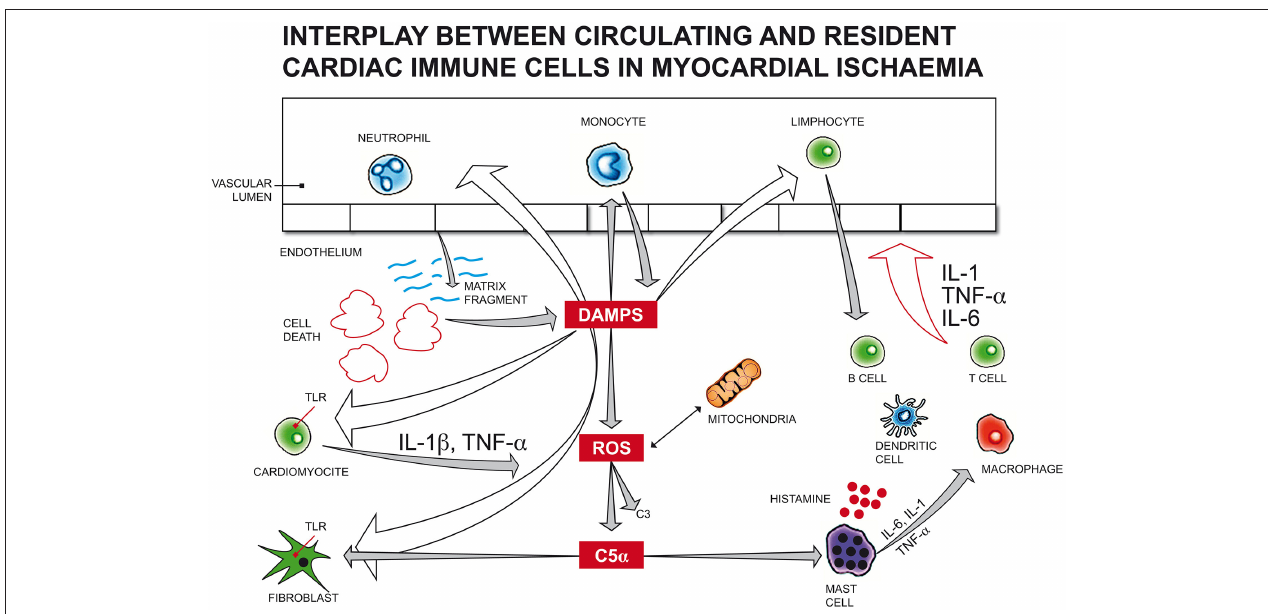
FIGURE 2 | Following myocardial infarction, cellular fragments released by dying or injured myocardial cells can trigger resident cardiac immune cells as endogenous “alarmins,” similar to microbial pathogen-associated molecular patterns (PAMPs) or damage-associated molecular patterns (DAMPs), through the engagement of membrane toll-like receptors (TLRs). Endogenous DAMPs can also activate the complement system, as observed with increased C3, C5 fragments in infarcted myocardial tissue, promoting leukocyte translocation in injured myocardium. Immune activation by DAMPs can arise also from mitochondrial DNA released by the mitochondria of damaged cardiac cells due to haemodynamic stress, inducing cardiomyocyte apoptosis. The generation of a large amount of reactive oxygen species (ROS) from mitochondria impairs myocardial function and activates leukocyte migration, reducing the number of vital cardiomyocytes and promoting extracellular matrix degradation. Many mediators of different origins can activate mast cells (MC) degranulation. In the first 24h after an acute ischaemic cardiac event, endogenous DAMPs induce the release of histamine, TNF- α , IL-6, prostaglandins, leukotrienes, tryptase, chymase and renin from MCs, leading to an acute immune response, which, in turn, actives resident immune cells, like macrophages, T, B, and dendritic cells. DAMPs, damage-associated molecular patterns; ROS, reactive oxygen species; C5 α , complement component 5 alfa; C3, complement component 3; TNF, tumor necrosis factor; IL-1/IL-1 β , Interleukin 1/Interleukin 1 beta; TLR, toll-like receptor; IL-6, Interleukin